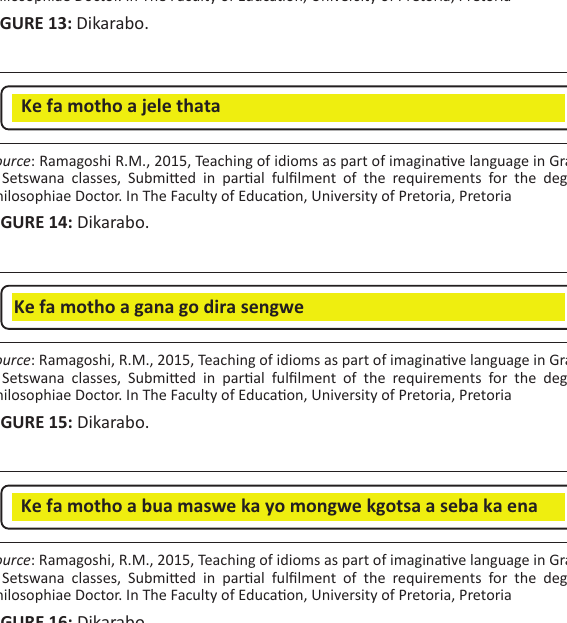
FIGURE 13: Dikarabo.